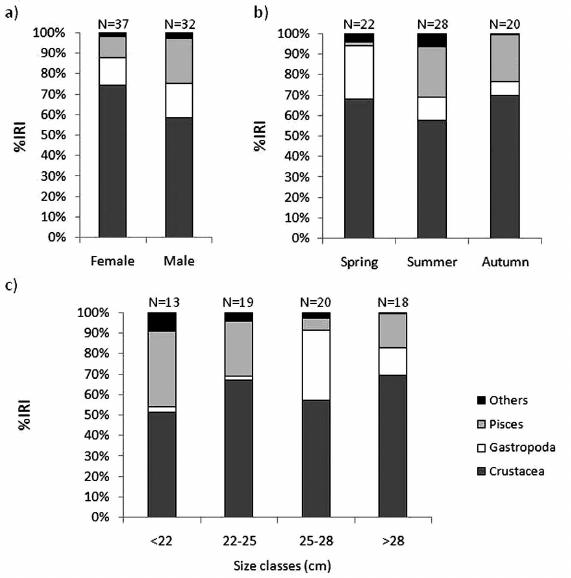
Fig . 10. – The diet composition of Labrus mixtus according to sex (A), season (B) and size (C) based on the index of relative impor- tance (%IRI) of the major prey groups. N is the number of analysed stomachs per group.